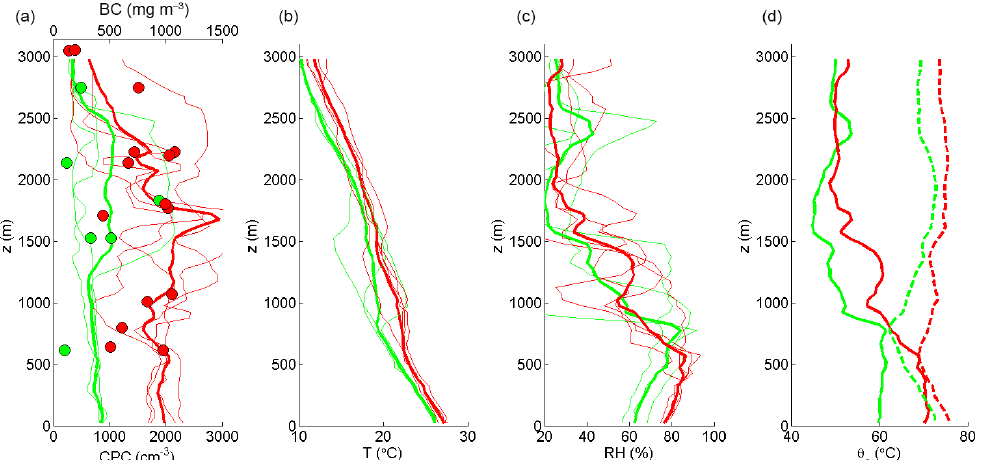
Figure 9. Profiles of (a) aerosol, (b) temperature, (c) relative humidity, and (d) equivalent potential temperature θ e from MAC4 for low- (Case L; green) and high- (Case H; red) pollution cases. Thin lines indicate the individual flights, and the thick line shows the mean of each case. There were three and five flights with this aircraft, sampling low- and high-pollution dry conditions, respectively. In the left panel, CPC-measured aerosol concentration (cm − 3 ) is indicated by lines, while BC retrievals (ngm − 3 ), which required a period of level flight to obtain an accurate measurement, are indicated by colored circles. Case H has significantly higher aerosol concentration at all altitudes, although this does not universally show an elevated aerosol plume. This case is coincident with warmer atmospheric temperatures and higher humidity at all altitudes. The saturation equivalent potential temperature θ ∗ e is shown as dashed lines in (d) . Note that due to missing pressure data in two of the MAC4 flights, the calculated variables θ e and θ ∗ e were determined using two less flights compared with (a) – (c) .